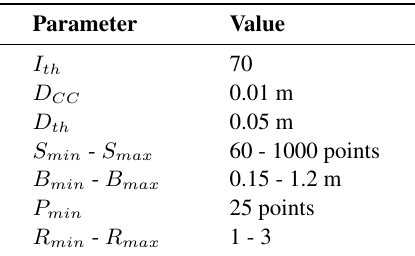
Figure 6. Shows the minimum bounding rectangle in magenta computed using RANSAC with the less optimal bounding rect- angles in blue. Green point within the magenta rectangle are inliers while red points are the outliers. Table 1. Summary of the different parameters and their corres- ponding